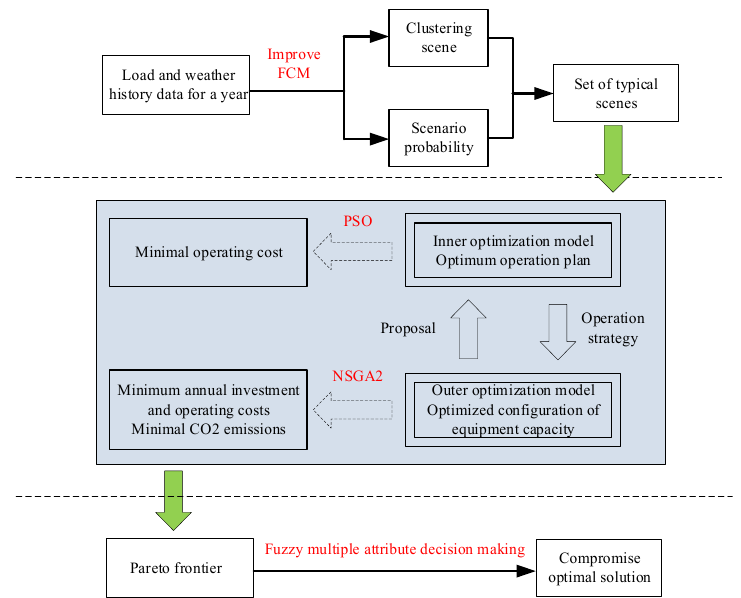
Figure 9. Flow chart of bi-level optimization configuration model.